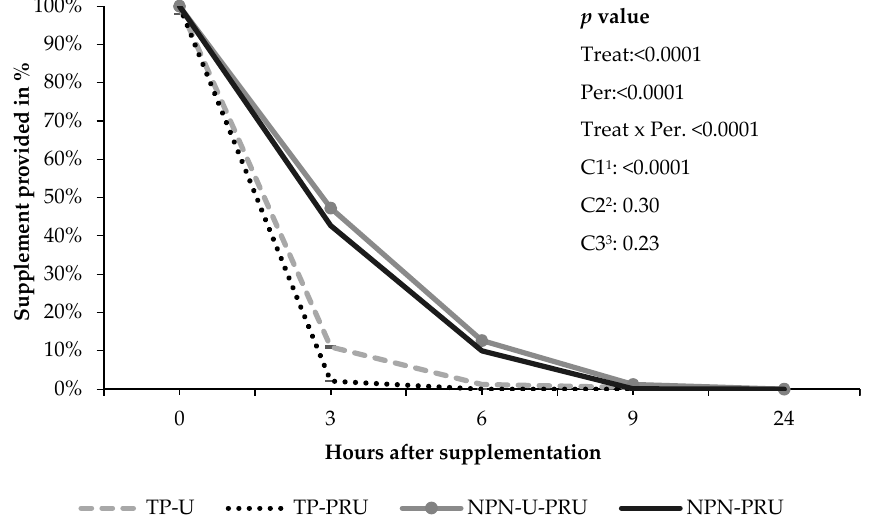
Figure 4. Rate of supplement disappearance over the experimental period of performance animals. Contrasts: 1 C1—TP-U/TP-PRU vs. NPN-U-PRU/NPN-PRU (Soybean meal replacement by NPN). 2 C2—TP-U vs. TP-PRU (conventional urea vs. PRU); 3 C3—NPN-U-PRU vs. NPN-PRU (low and high post-ruminal urea (PRU) level) SEM: 1.21 (error average default.) Hour 0 corresponds to the total amount of supplement